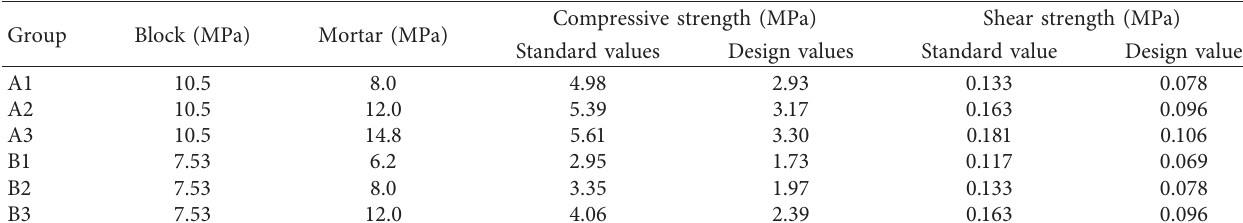
Table 8: Standard and design values of compressive and shear strengths of RCB masonries.